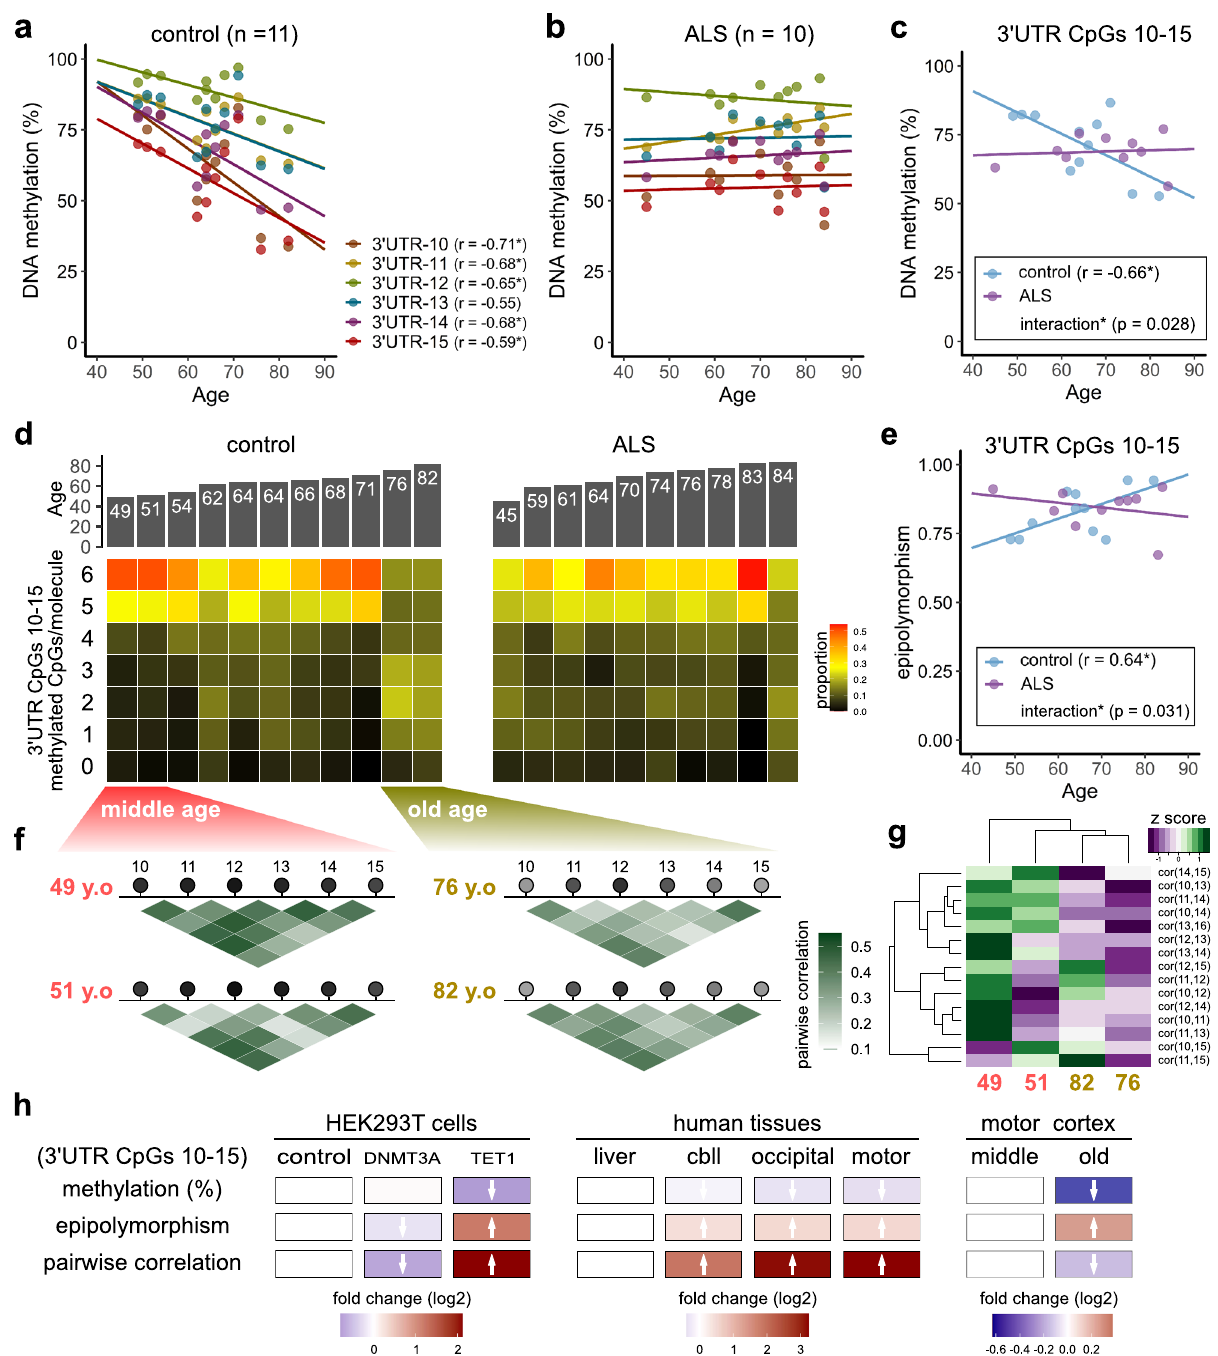
Fig. 6 Effect of aging on the DNA methylation status of the TARDBP 3 ′ UTR in the motor cortex. a, b Scatter plot showing the percentage of DNA methylation at each CpG site among TARDBP 3 ′ UTR CpGs 10 – 15 according to age at autopsy (Pearson ’ s correlation test) in the control ( a ) and ALS ( b ) groups. c Scatterplot showing the average DNA methylation of 3 ′ UTR CpGs 10 – 15 according to age at autopsy in the controls (Pearson ’ s correlation test). d Proportions of the number of sequence reads classi fi ed by the number of methylated CpGs among the six CpG sites (3 ′ UTR CpGs 10 – 15) in the controls and ALS patients. e Correlation between age at autopsy and the epipolymorphism scores of 3 ′ UTR CpGs 10 – 15 (Pearson ’ s correlation test). f , g Methylation-linkage diagram of 3 ′ UTR CpGs 10 – 15 in two of the youngest and two of the oldest individuals analyzed ( f ) and heat map ( g ) showing the extent of the pairwise correlation of each CpG pair. h For each DNA methylation pro fi le, the effects of the targeted manipulation of DNA methylation, differences according to brain region, and the effect of aging are shown as fold changes (log2) relative to the experimental control, liver, and middle-aged group results,